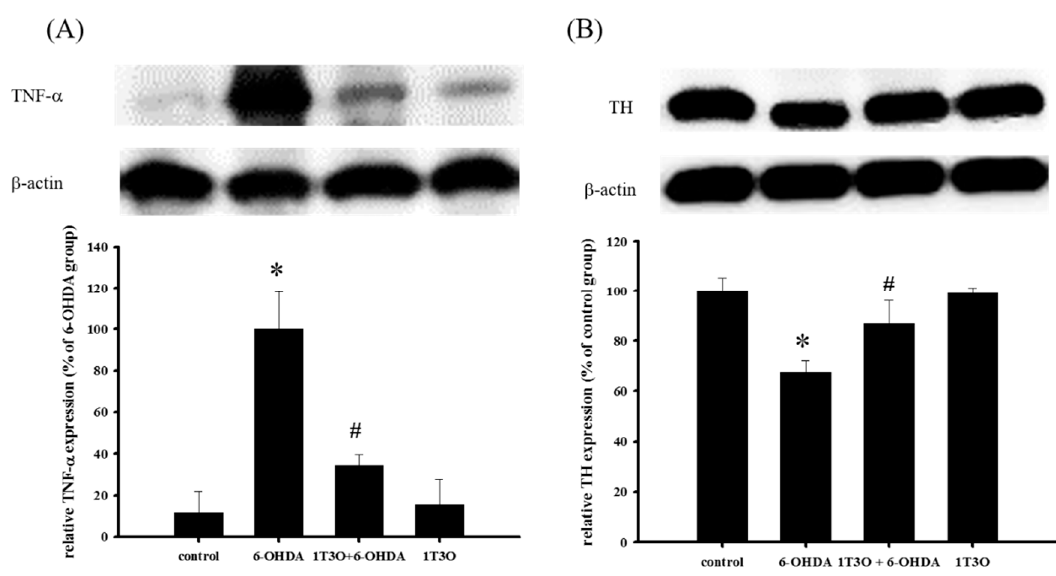
Figure 11. Effect of 1T3O on 6-OHDA-induced increase in inflammatory factor TNF- α expression and decrease in tyrosine hydroxylase (TH) expression in zebrafish brain tissue. Western blot was used to analyze expression of TNF- α and TH protein, and to study the effect of 1T3O on 6-OHDA-induced elevation in TNF- α expression and reduction in TH expression. Results showed that 1T3O can ameliorate 6-OHDA-induced increase in TNF- α and decrease in TH. Data are presented as mean ± SEM. Total number of animals = 12; * p < 0.05 vs. Control; # p < 0.05 vs. 6-OHDA group.